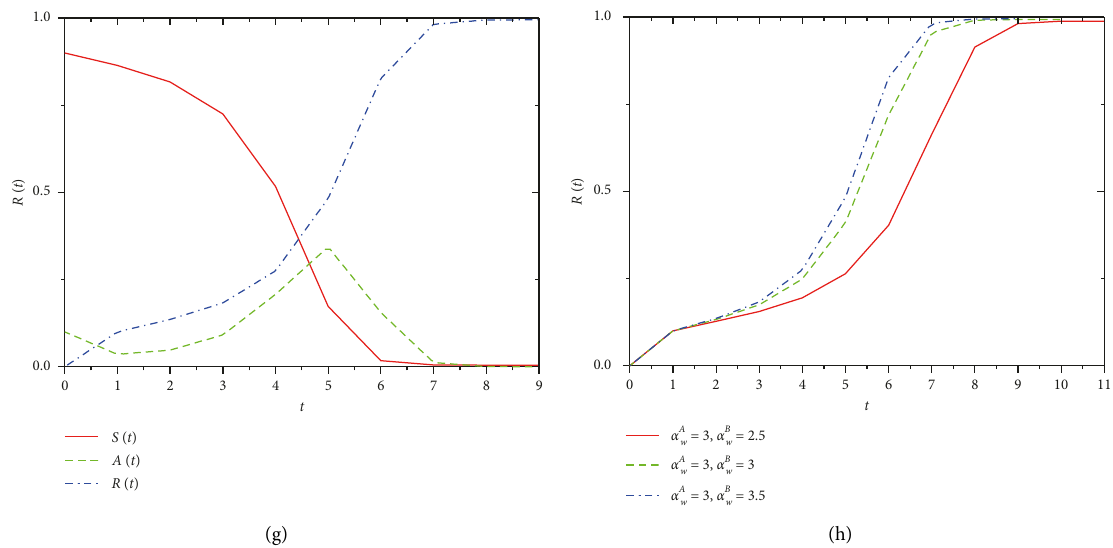
Figure 2: Time evolutions of node densities in three states (S-state, A-state, and R-state) on the ER-ER weighted multiplex network, under and α B . To unveil the effect of the threshold and seed size, two groups of subgraphs with different weight distribution exponents α A ω ω T � 1 ; T � 2 ; ρ � 0 . 03 and T � 1 ; T � 3 ; ρ � 0 . 1 are shown in the top and bottom panels, respectively. Under the same information A B A B 0 0 transmission unit probability β , subgraphs (a), (b), and (c) from the top panel have similar parameters of α A � 3, α B � 3 . 5 with (e), (f), and (g), respectively. Particularly, subgraphs (d) and (h) emphasize the time evolution of the R-state node and α A ω ω density R ( t ) under different weight distribution exponents. In both panels, despite the different thresholds and seed sizes, at the same time � 3 , α B � 3 . 5 exceeds other densities under α A step, the density of nodes in the R-state under α A ω ω phenomena suggest that large weight distribution exponents (small weight distribution heterogeneity) facilitate information spreading. The basic parameters are N � 10 4 , 〈 k 〉 � 10, 〈 ω 〉 � 8, c � 1 . 0, and β � 0 .